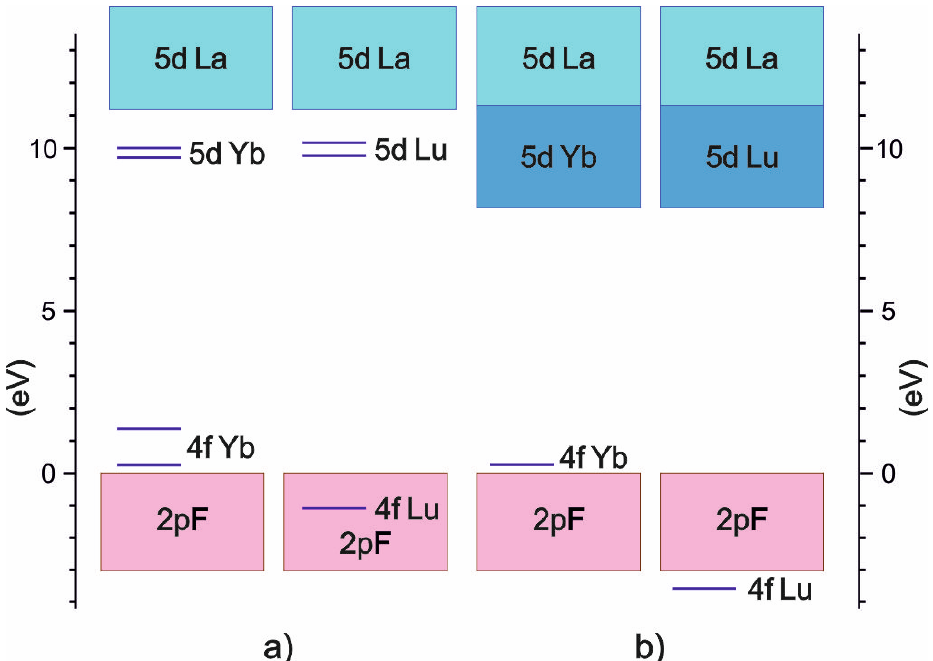
Figure 5. Scheme of energy levels of impurities in LaF 3 :Yb and the LaF 3 :Lu crystals (( a )—experimental results [2], ( b )—calculated results).